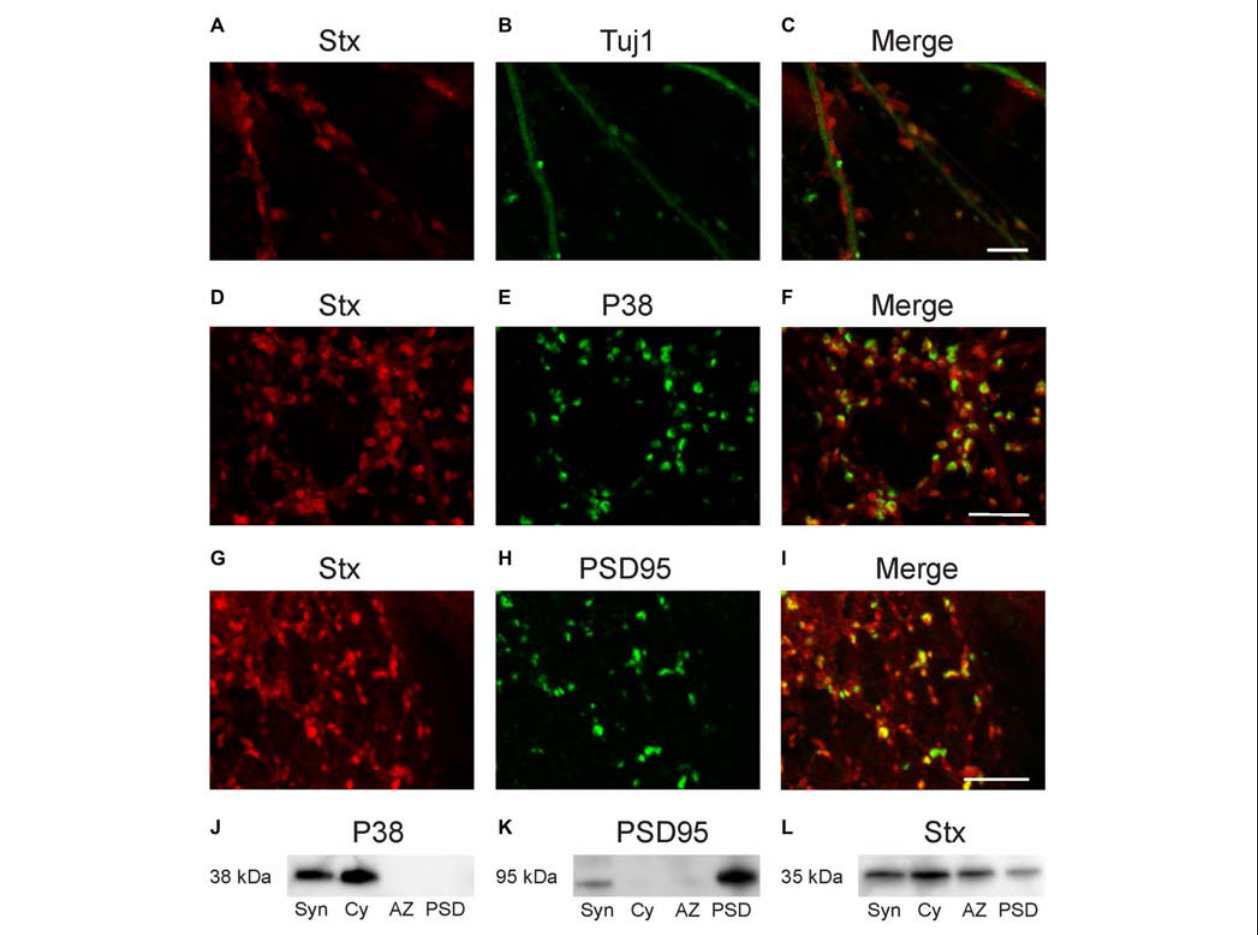
FIGURE 4 | Confocal images of dissociated hippocampal cultures. Double labeling with anti-syntaxin-1 (A) and anti-Tuj1 (B) demonstrates that syntaxin-1 is located along the dendrites and gives characteristic punctate labeling (C) . Double labeling with antibodies against syntaxin-1 (D) and synaptophysin (E) indicates that syntaxin-1 is colocalized with presynaptic marker (F) . Double labeling for syntaxin-1 (G) and PSD-95 (H) shows partial colocalization postsynaptic (I) . Scale bars: 10 µ m. (J–L) Western blot analysis of synaptosomes (Syn), synaptic cytosolic fraction (Cy), active zone (AZ) and post synaptic density (PSD). Labeled with anti-synaptophysin (J) anti-PSD95 (K) and anti-syntaxin-1